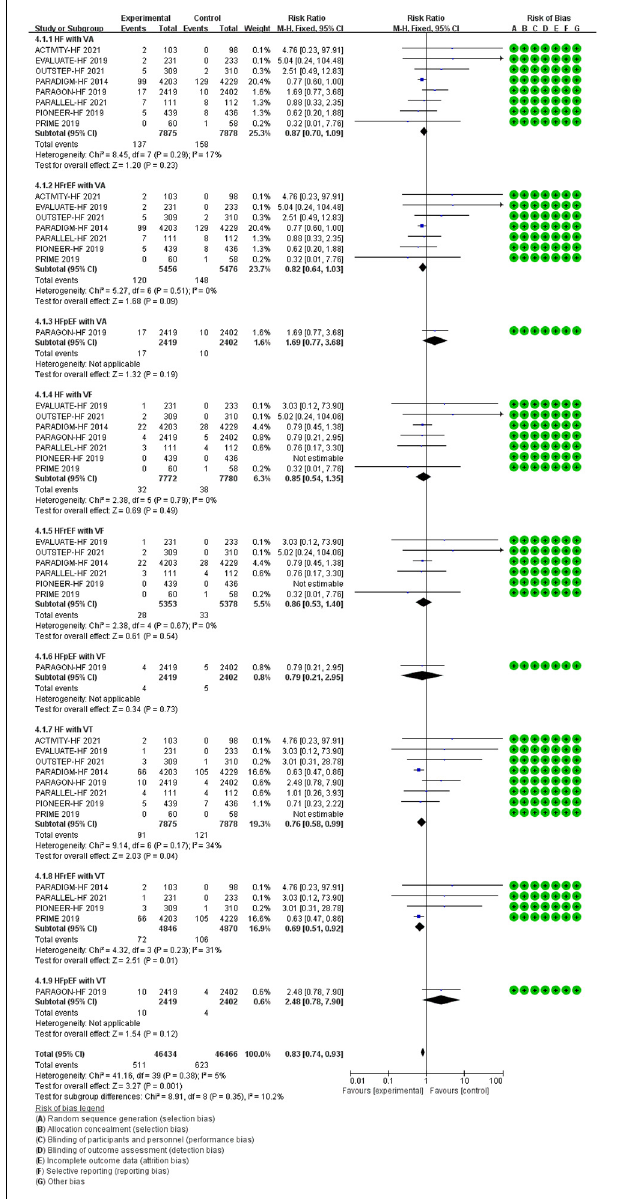
FIGURE 7 | The efficacy of SV compared to ACEI/ARB on